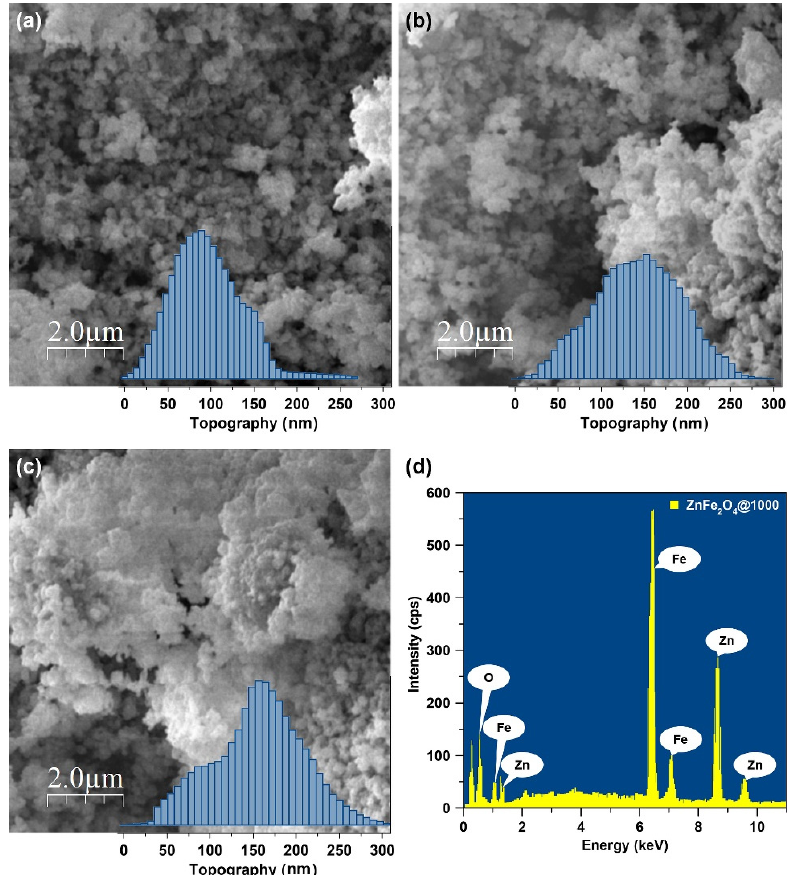
Figure 4. Scanning electron microscopy images of ZnFe 2 O 4 nanoparticles annealed at ( a ) 600, ( b ) 800, and ( c ) 1000 °C. The respective histograms are given in the inset. ( d ) Energy-dispersive X-ray spectrum of ZnFe 2 O 4 nanoparticles annealed at 1000 °C.